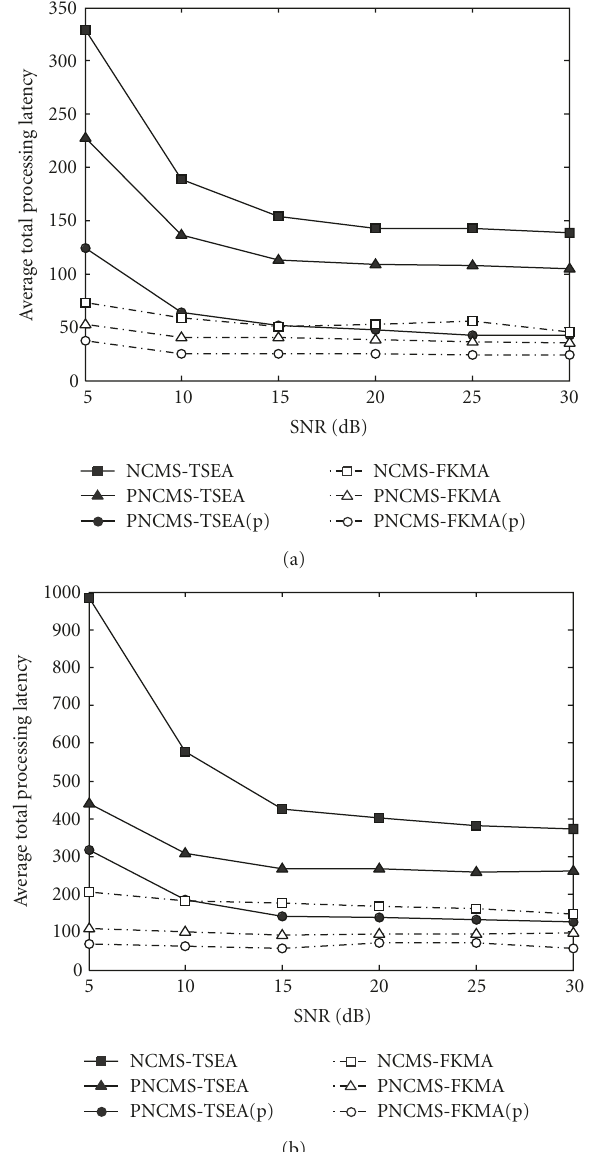
Figure 7: Processing latency comparison results of Case C in Part C (average total processing latency versus SNR): (a) A = A 1 and (b) A = A 3